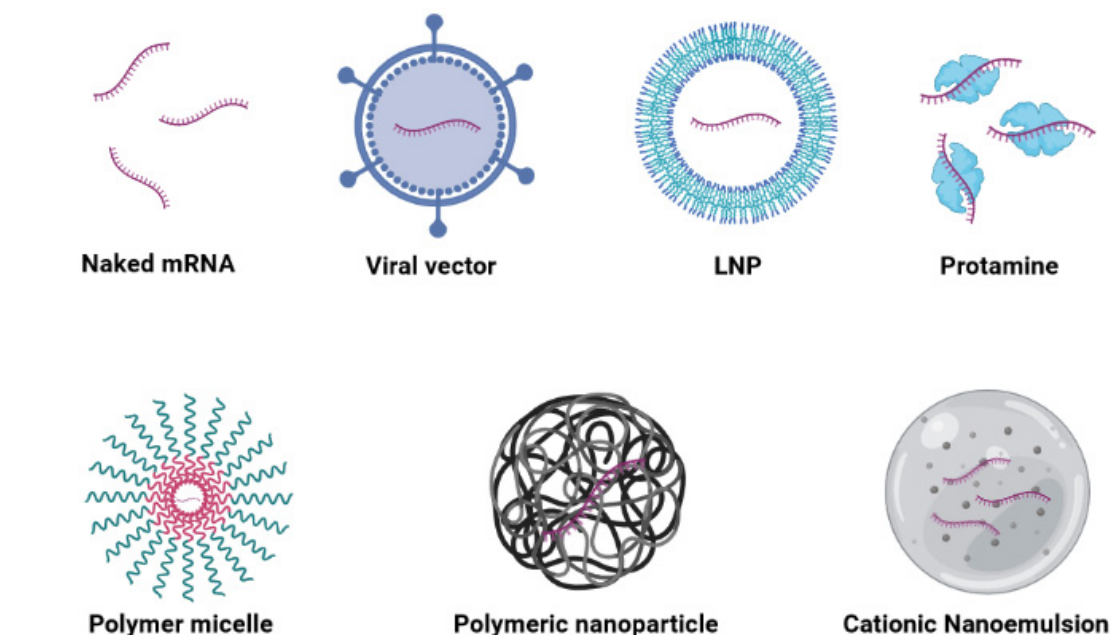
Figure 3. Various carriers for mRNA vaccine delivery.